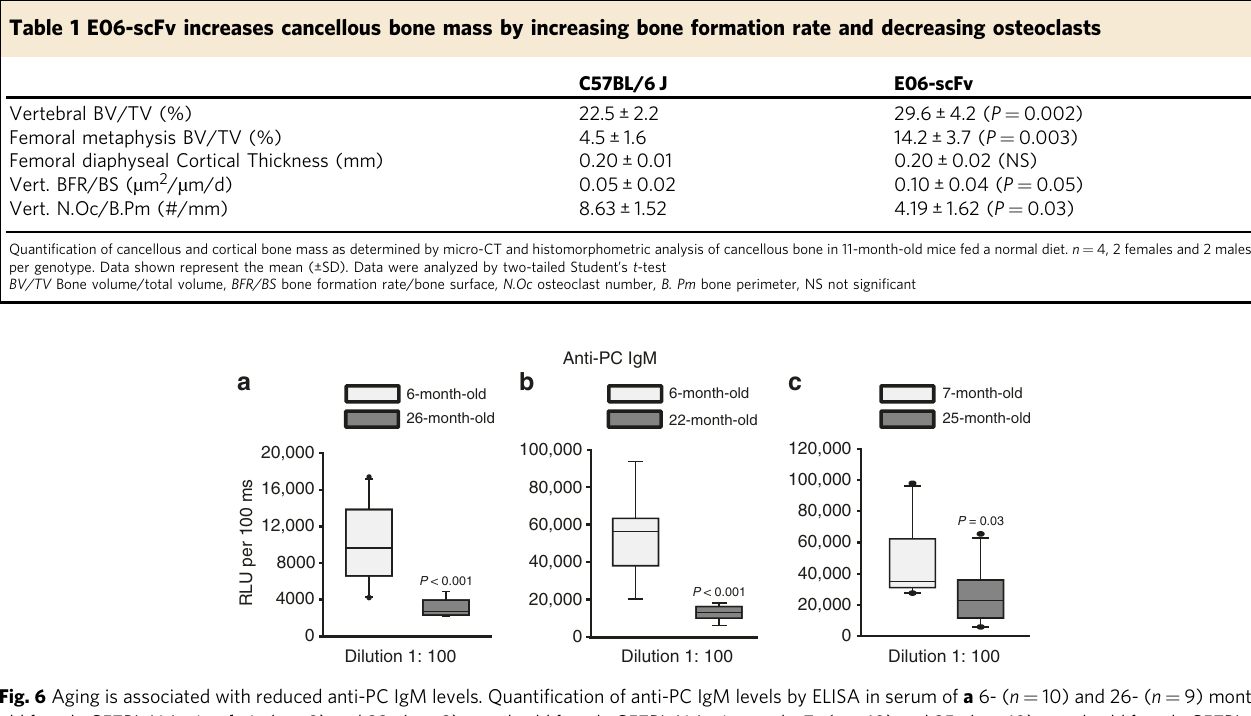
E06-scFv mice fed a normal diet (Table 1). Histomorphometric